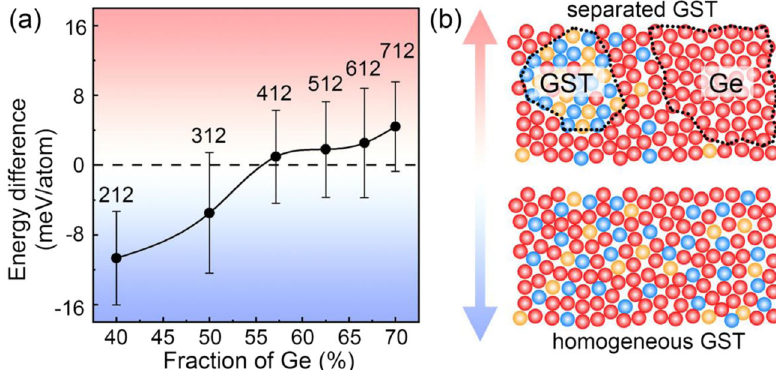
Fig. 5 Energy analysis of the phase segregation. a The energy difference E diff of amorphous Ge-rich GST with respect to amorphous Ge 1 Sb 2 Te 4 and amorphous Ge as a function of the Ge concentration, as de fi ned in the text. Each data point is averaged over three samples of a speci fi c Ge-rich GST alloy, three samples of amorphous Ge 1 Sb 2 Te 4 and three samples of amorphous Ge. The large error bars are mostly contributed by the energy fl uctuations of amorphous Ge 1 Sb 2 Te 4 and amorphous Ge models, due to their limited system size. b The sketches of separated GST phase and homogeneous GST phase. Positive E diff values reveal an intrinsic tendency toward phase separation into amorphous Ge 1 Sb 2 Te 4 and amorphous Ge, while negative E diff values indicate that the amorphous models are energetically favorable in the homogeneous